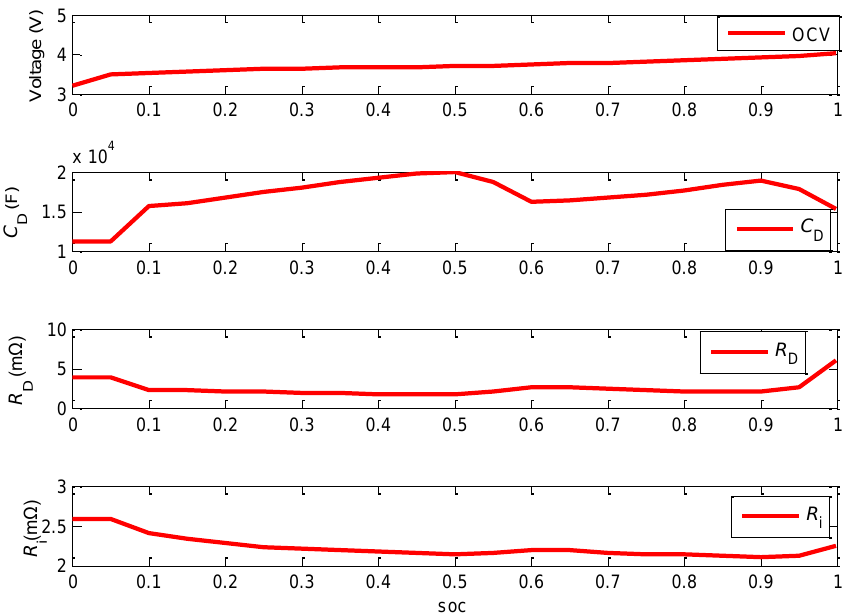
The identified parameters of OCV, C D , R D and R i are plotted in Figure 2. The detailed parameter identification process can be found in [5]. Figure 2. The parameters’ change under different state of charge ( SOC